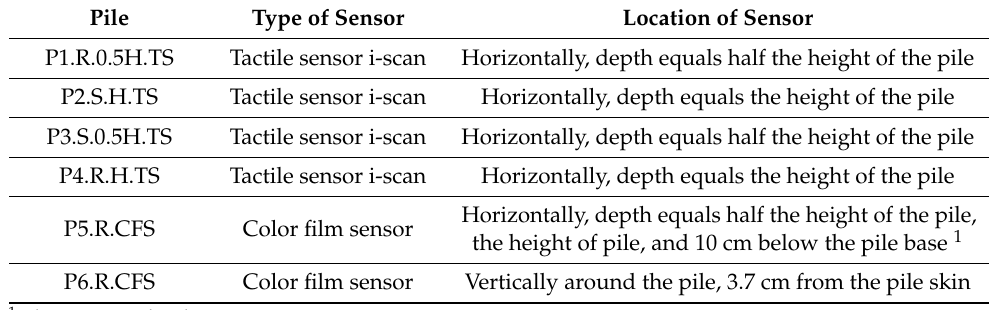
Table 2. Type of sensors and localization used in pile load tests.